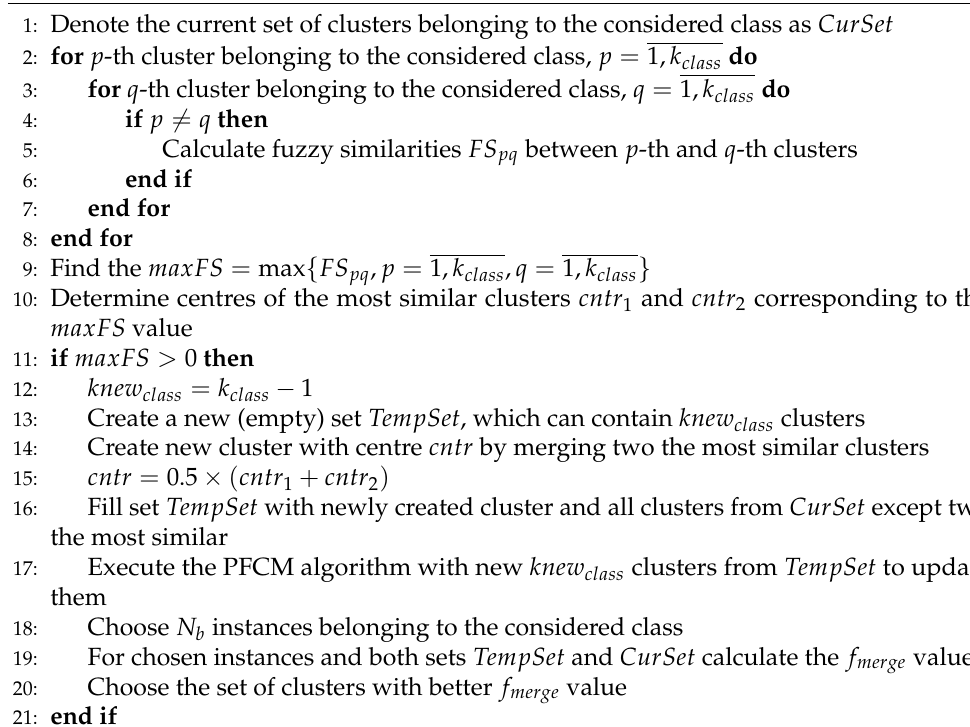
Algorithm 3 The merging